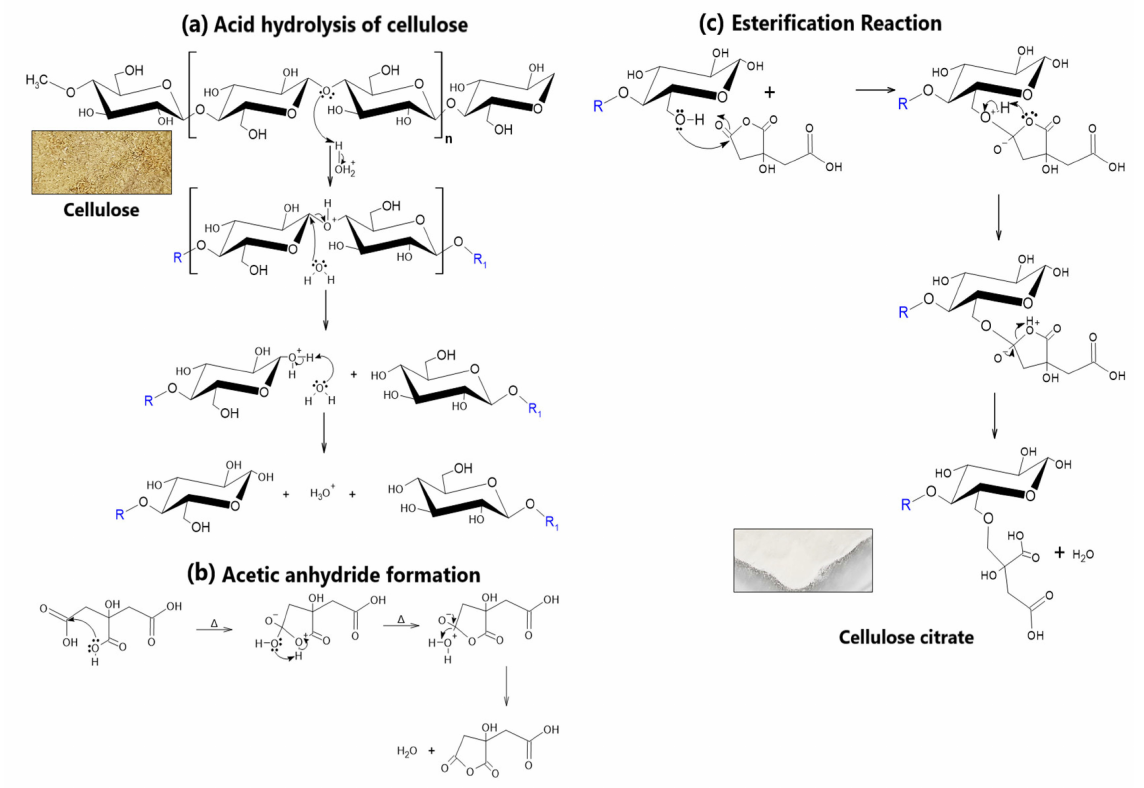
Figure 2. ( a ) Corn husk cellulose and acid hydrolysis reaction, ( b ) formation of citric anhydride, ( c ) esterification reaction and cellulose citrate